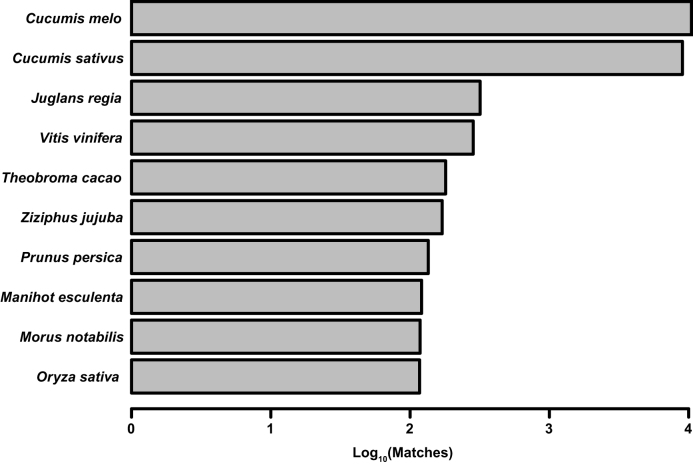
Number of best-matching proteins for each predicted S. grosvenorii gene by species.